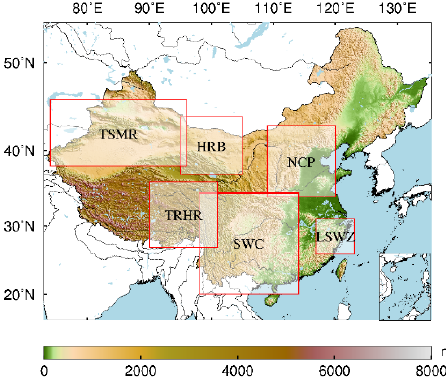
Figure 1. Overview map of the study area in China.